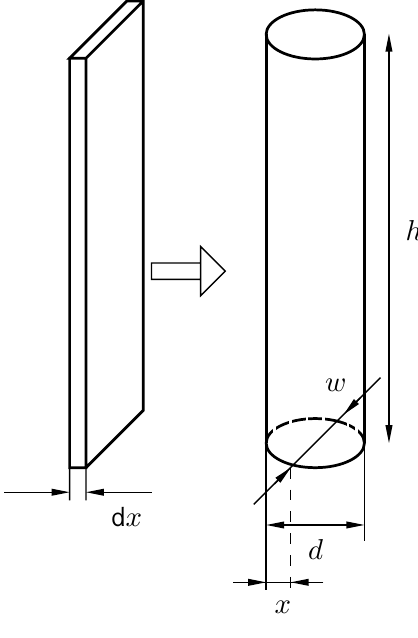
Table 3. The ratio X , defined in Eq. (17), calculated for the values of M and cos α given in Table 2 that were used to integrate the solitary waves in Figs. 5 and 6.